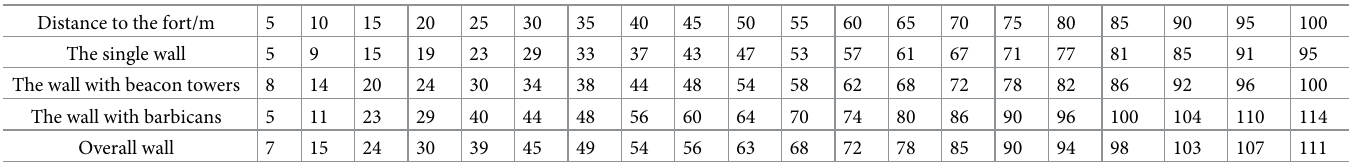
Fig 10. Model of the firepower value distribution of the walls: a-The single wall; b- The wall with beacon towers; c-The wall with barbicans; d-The overall wall. https://doi.org/10.1371/journal.pone.0282537.g010 battlements is 1 m. The width of battlements is about 350–500 mm. And the batter of the wall is about 20%. When integrated with the horizontal firepower distribution analysis presented above, it is apparent that the moat represents the initial fire attenuation barrier. In addition, the moat can Table 4. Measurement table of fortifications on firepower